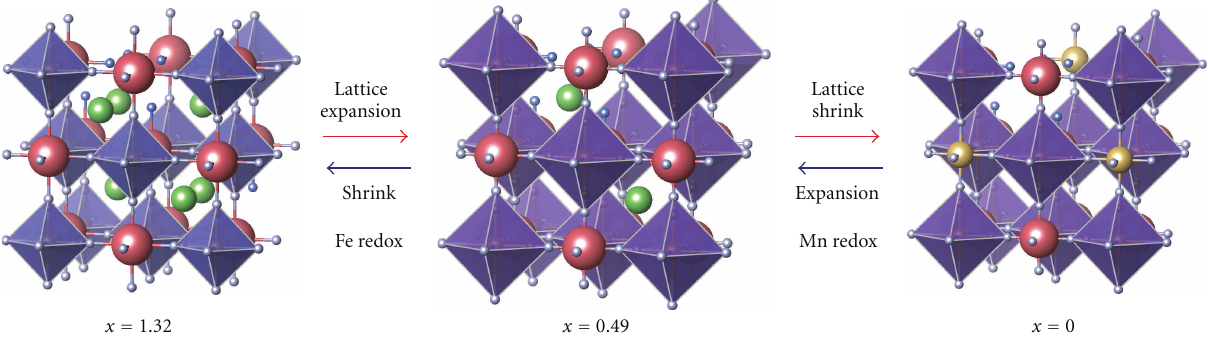
· 3 . 5H ] 2 O thin film. Blue and purple polyhedra represent 6 0 . 83